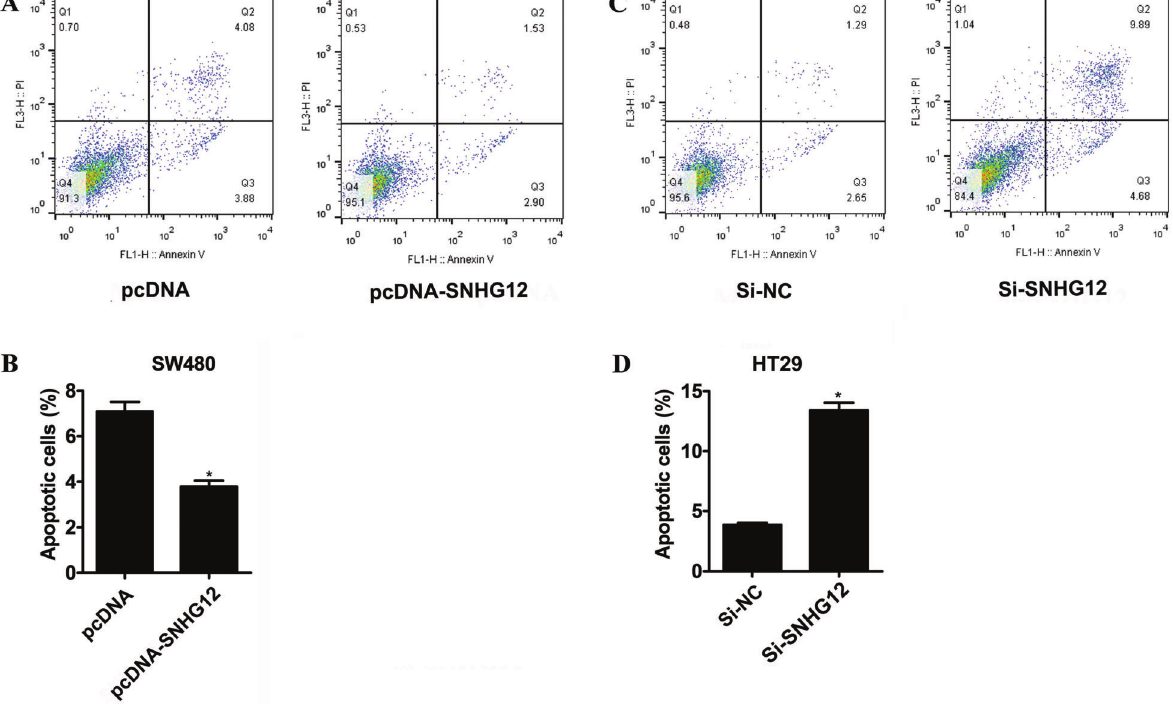
Figure 5. Flow cytometric analysis for cell apoptosis ( A ) and the corresponding statistical result ( B ) in SW480 cells transfected with pcDNA- SNHG12 and in HT29 cells transfected with si- SNHG12 ( C and D , respectively). Data are reported as means ± SD. *P o 0.01 vs control (Student ’ s t